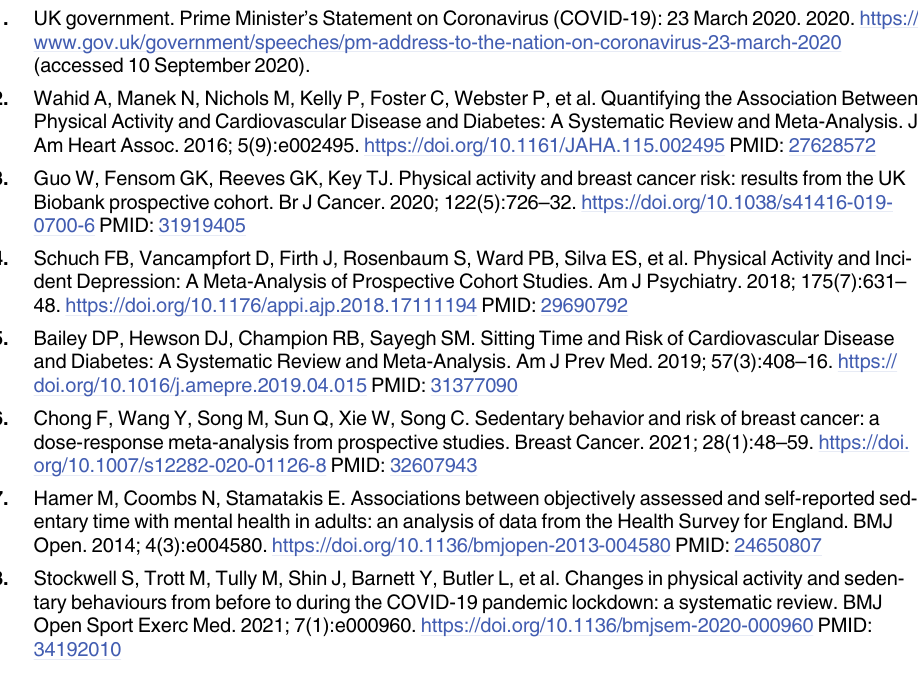
S1 Table. Weekend day sitting categories before and during lockdown (data presented as